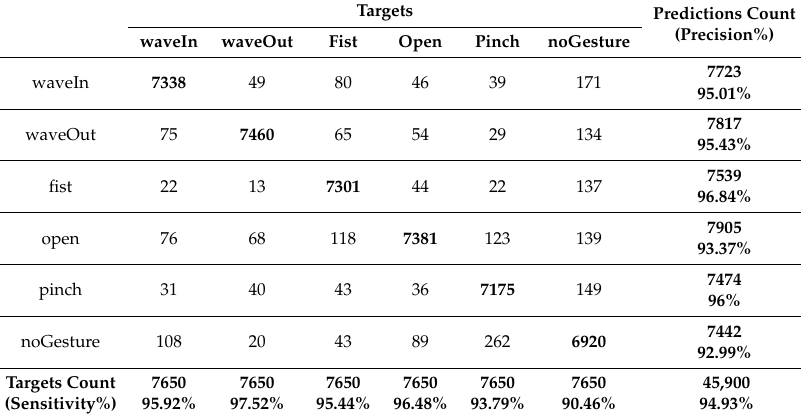
Table 5. Confusion matrix of experiment 3 for the user-specific model. Rotation of the bracelet = YES (on the test set), orientation correction = YES . Best result with four synchronization gestures ( sync = 4 ) to select the maximum average energy sensor s x . Classification accuracy = 94.93%.